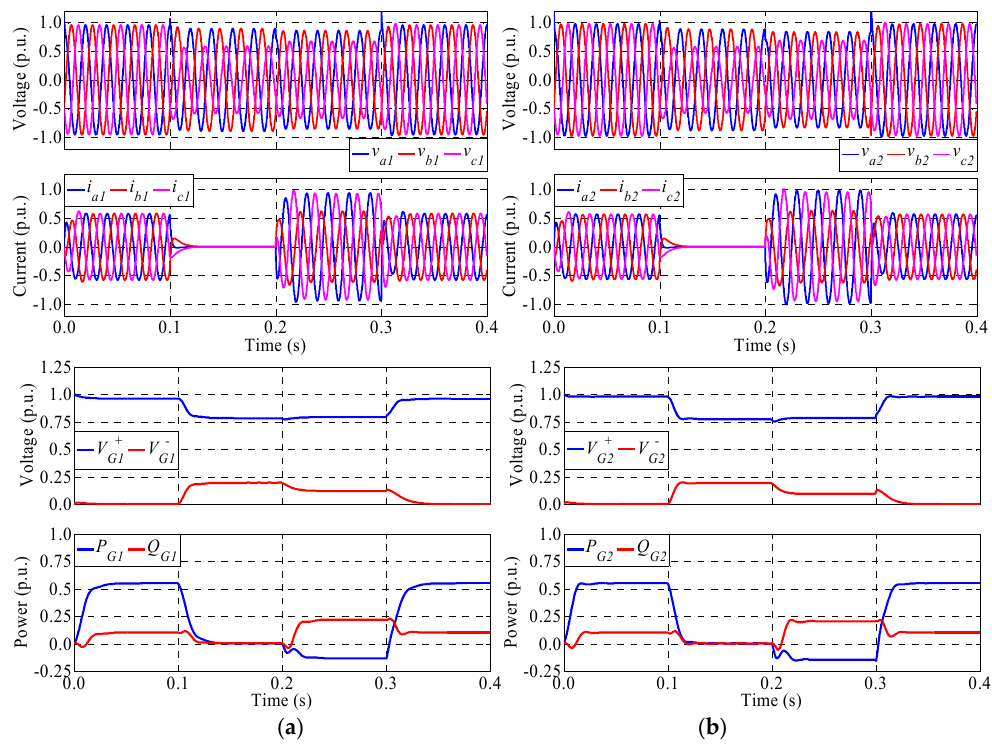
Figure 10. Main waveforms of ( a ) generator 1 and ( b ) generator 2 using the GCVS control scheme for type I voltage sag.